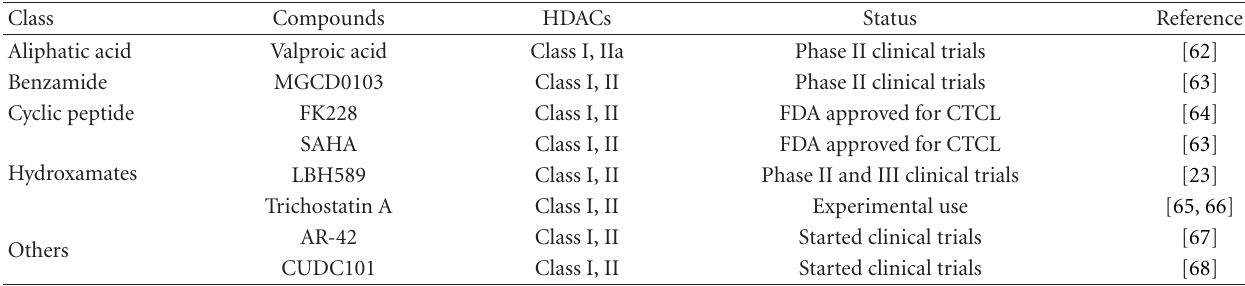
Table 2: Major HDAC inhibitors: Targets and current status in cancer